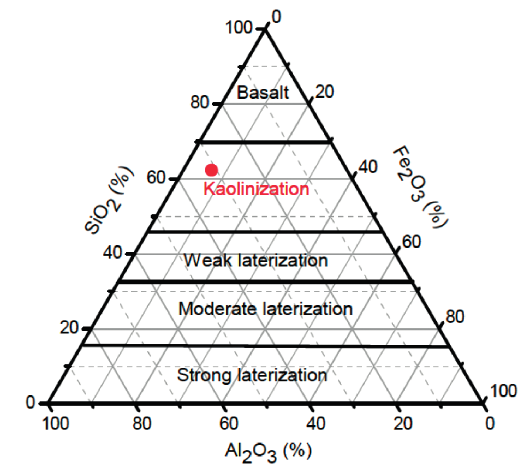
Fig. 1. Chemical compositions of the WMF and soil sample Fig. 2. Al